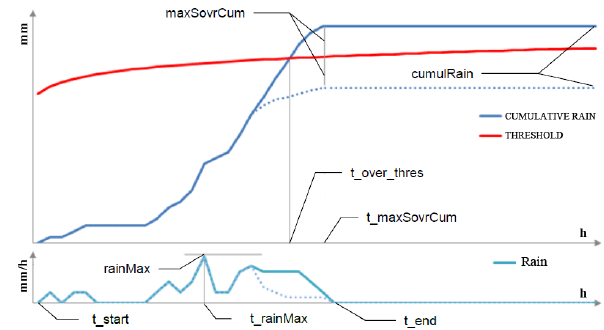
Figure 4. Parameters used to characterize each rainfall event stored in the database: t_start and t_end is the time when the rainfall event starts and ends, respectively; cumulRain is the final value of cumu- lative rainfall (mm); maxSovrCum is the maximum value exceed- ing the threshold (or minimum distance from the threshold when not exceeded) (mm); t_maxSovrCum is the time of occurrence of maxSovrCum; t_over_thres is the time when the threshold was first exceeded; rainMax is the maximum rainfall intensity (mmh − 1 ); and t_rainMax is the time of occurrence of rainMax. To show all the possible cases, two examples of rainfall events are represented: the dotted line refers to a rainfall event that does not exceed the thresh- olds, while the solid line represents a rainfall event that exceeds the